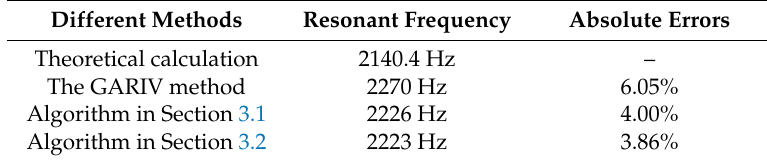
Table 2. Comparison of resonant frequencies obtained by different methods.